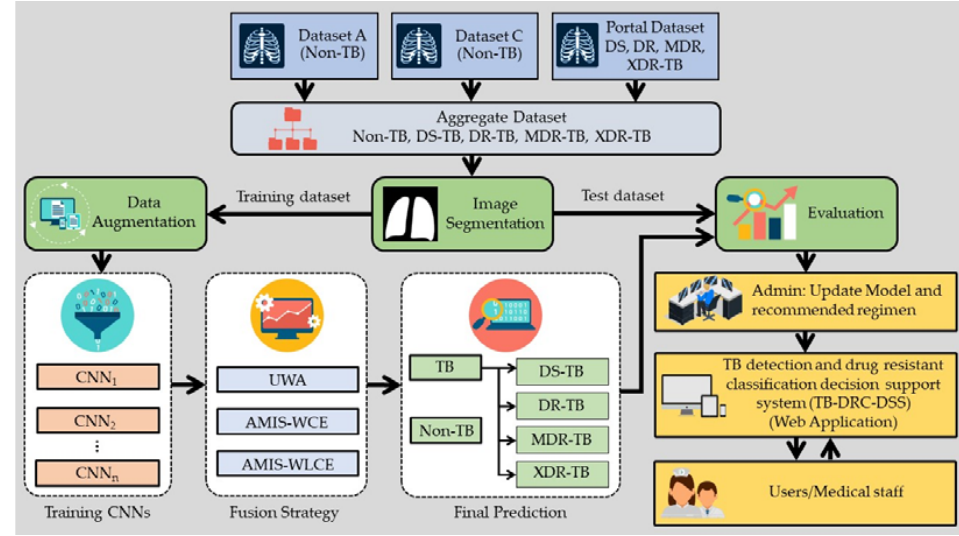
Figure 6. Framework of the proposed model .